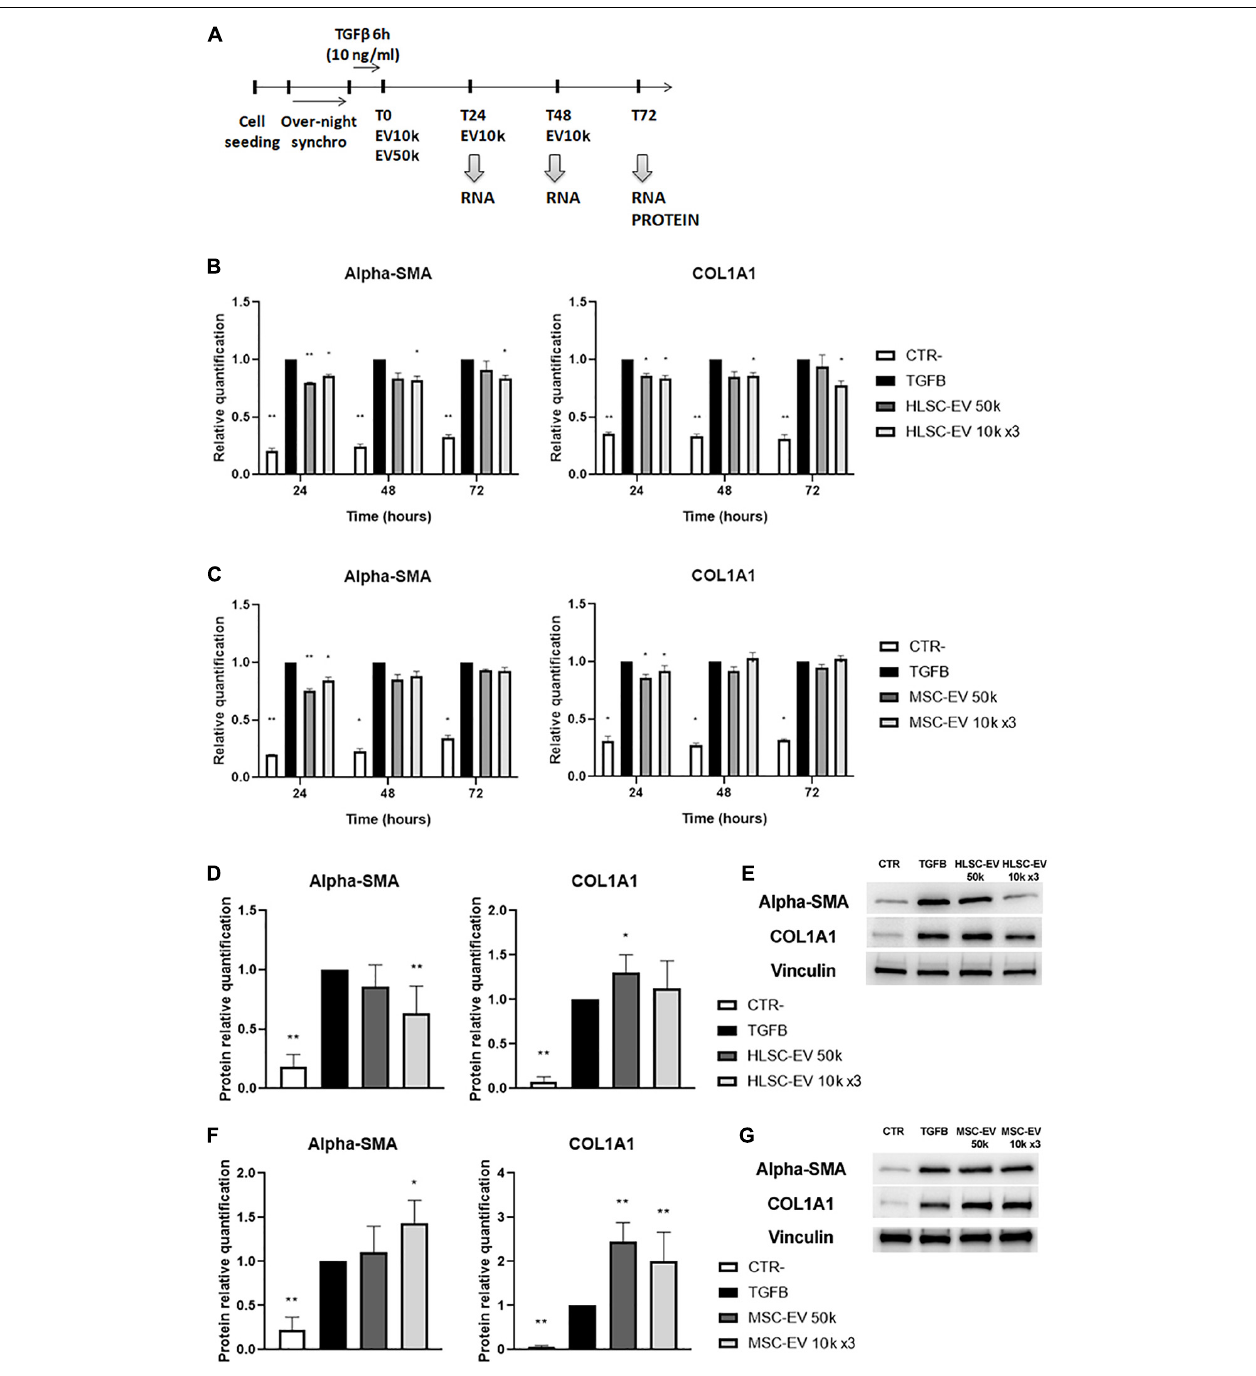
FIGURE 3 | EV effect on activated LX-2. (A) Schematic representation of the in vitro experimental design to test the effect of HLSC-EVs and MSC-EVs on LX-2, showing the timing of cell seeding, synchronization, stimulation with TGF- β 1, EV administration and RNA and protein collection from LX-2. (B,C) QRT-PCR analysis of the expression of pro-fibrotic genes in LX-2 after 24–48–72 h of incubation with HLSC-EVs (B) and MSC-EVs (C) . Gene expression levels were normalized on those of the housekeeping gene TBP. (D–F) Protein bands quantification (D,F) and representative images of western blot analysis (E,G) of pro-fibrotic markers in activated LX-2 stimulated with HLSC-EVs (D,E) and MSC-EVs (F,G) . Protein bands intensity was normalized on vinculin expression. For all experiments, LX-2 activated with TGF- β 1 (10 ng/mL) not incubated with EVs were used as reference control. LX-2 cultured without TGF- β 1 were used as negative control (CTR-). Statistical analysis was performed on results obtained from at least three independent experiments using the Two-way ANOVA test: * p < 0.05; ** p < 0.01.